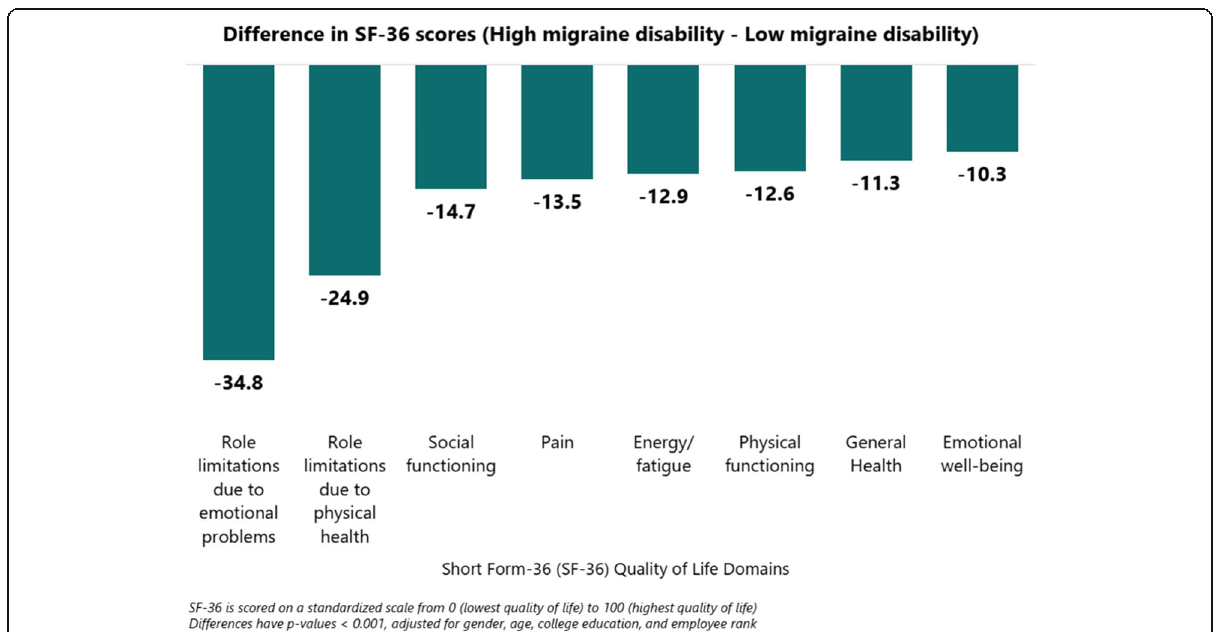
Fig. 2 Adjusted differences in Short Form-36 (SF-36) quality of life scores between low and high migraine disability. Notes: Models were adjusted for gender, age, educational attainment, and employee